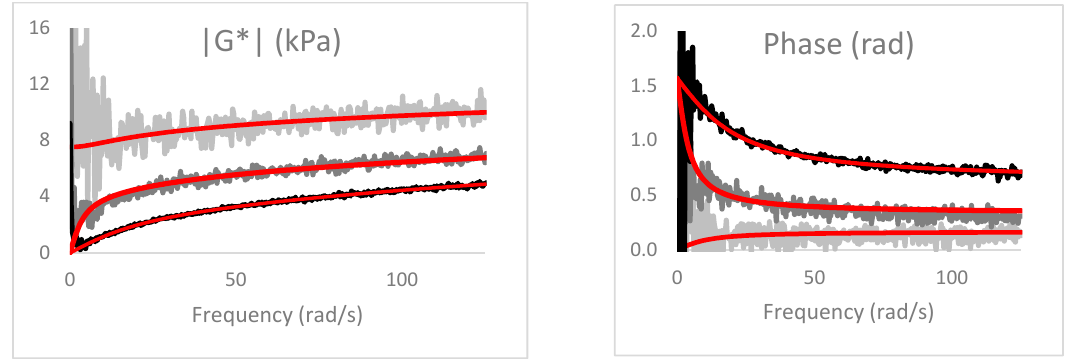
Figure 12. Frequency response for ethyl vinyl acetate (EVA) at 97 °C (experimental), and the modelled impedance